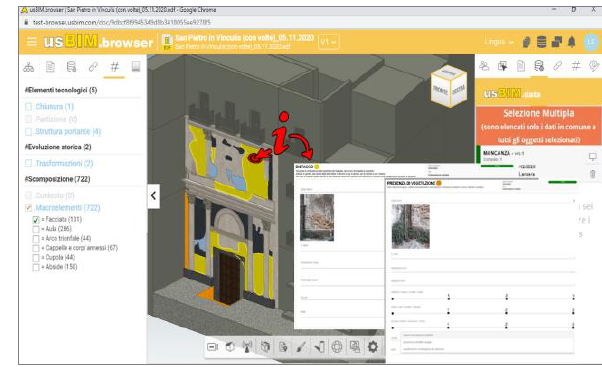
Figure 8 . The Heritage BIM Toolbar ( Edificius - ACCA software).